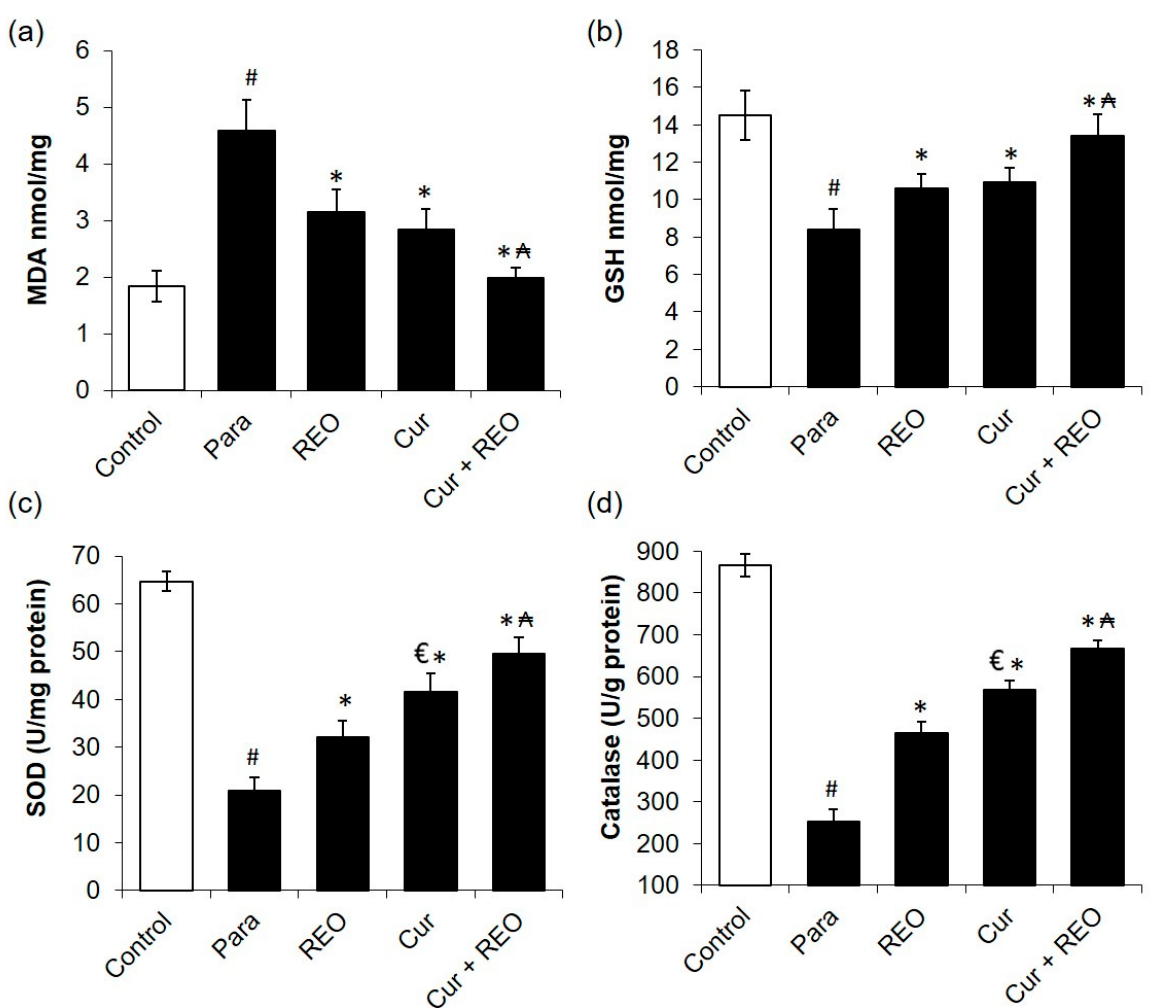
Figure 4. The effect of pretreatment with curcumin (Cur) and rosemary essential oil (REO) on ( a ) MDA, ( b ) GSH, ( c ) SOD, and ( d ) CAT activities in paracetamol (Para) induced liver toxicity in mice. Each column represents the mean ± SD ( n = 6). The symbol # designates statistically significant compared to the control group, * defines statistically significant compared to the Para group ( p < 0.05), € describes statistically significant compared to the REO group ( p < 0.05), and ₳ designates statistically significant compared to the Cur and REO groups ( p < 0.05) using one-way ANOVA followed by Tukey’s post hoc